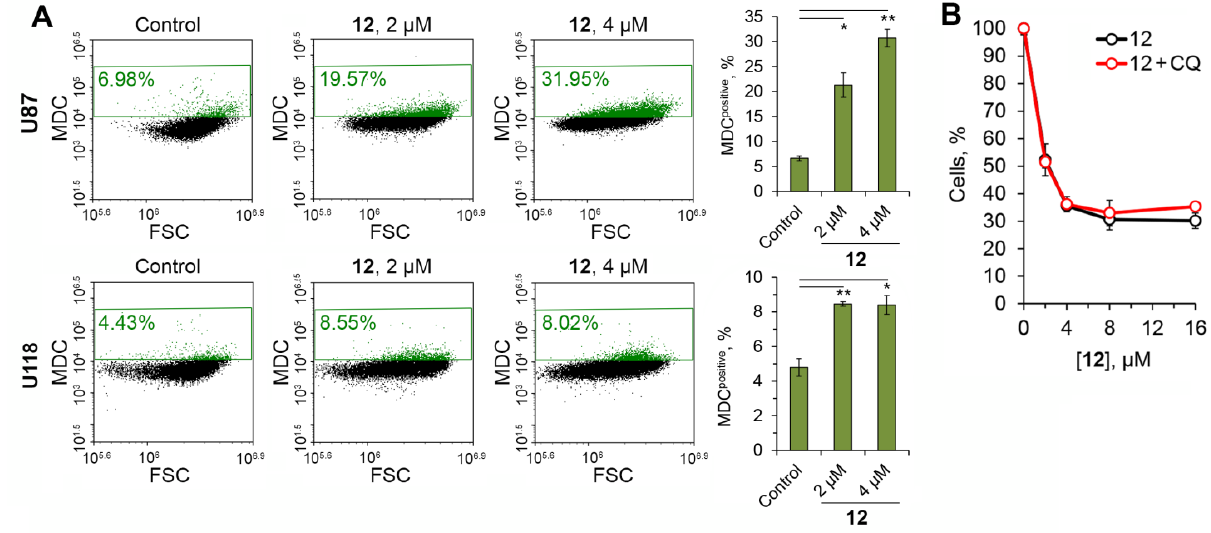
Figure 5. Evaluation of autophagy-induced activity of 12 in glioblastoma cells. ( A ) Representative density plots of flow cytometry analysis of U87 and U118 cells treated with 12 for 24 h and stained with monodancylcadaverine (MDC). The histograms on the right show the percentage of MDC-positive autophagic cells in the control and compound 12 -treated samples. Data are expressed as means ± SD of four independent experiments. * p < 0.05; ** p < 0.01. ( B ) The cytotoxicity of 12 in U87 cells in the absence and presence of chloroquine (CQ). U87 cells were treated with 12 and CQ (50 µM) for 24 h followed by the measurement of cell viability using MTT assay ( n = 4).